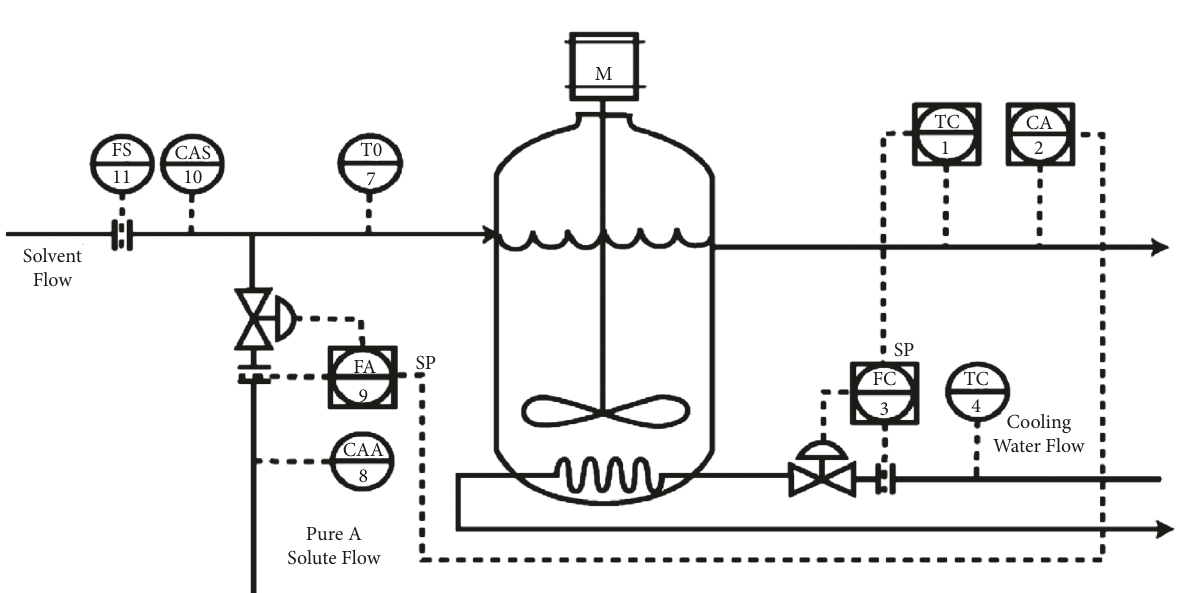
Figure 5: Simplified schematic of the CSTR [22, 33].